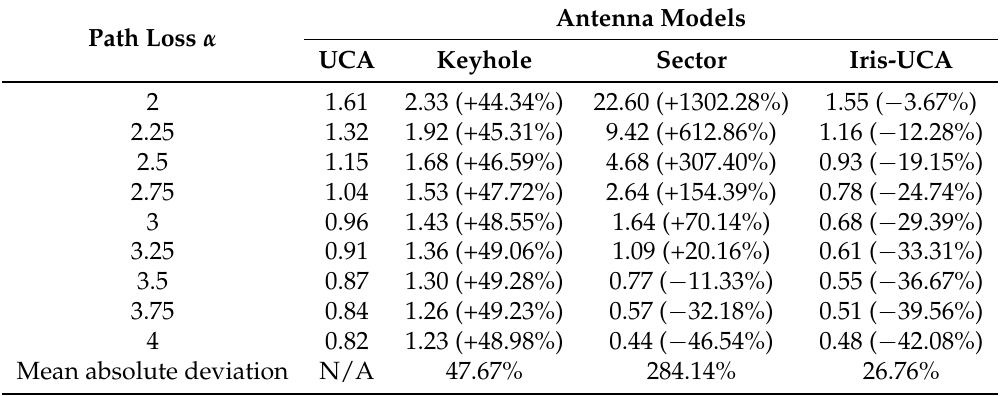
Table 2. E [( G r G t ) 2 α ] of the UCA antenna, keyhole, sector and iris-UCA with deviations compared with the UCA